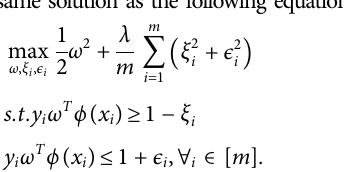
The four transformation operators of the dynamic state transition algorithm covered the fast rotation